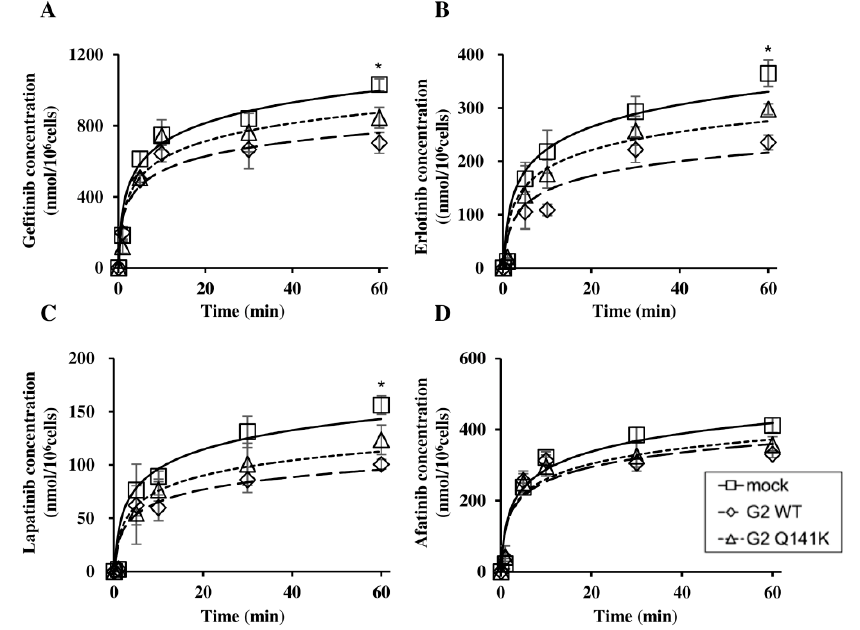
Figure 4. Intracellular accumulation of EGFR TKIs. Each EGFR TKI (gefitinib ( A ), erlotinib ( B ), lapatinib ( C ), or afatinib ( D ) at 20 µ M) was added to Flp-In-293 / mock cells, Flp-In-293 / ABCG2 WT cells, and Flp-In-293 / ABCG2 Q141K cells, followed by incubation for 0, 1, 5, 10, 30, or 60 min and measurement of the intracellular EGFR TKI concentration. P -values were determined by Student’s t -test (* P < 0.05 compared G2 WT with G2 Q141K at 60 min). Data are expressed as the mean ± SD. Each experiment was repeated three times.